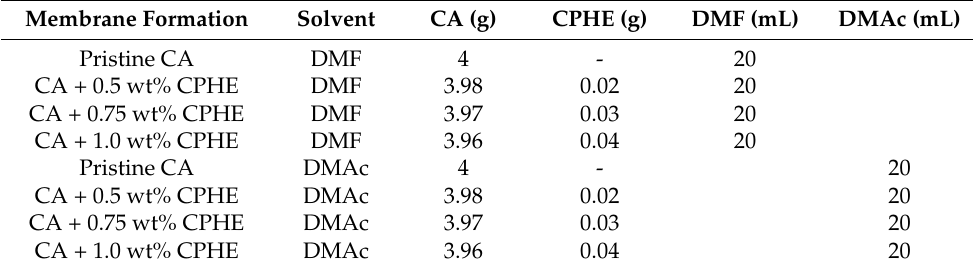
Table 1. Combinations of CPHE nanopowder, CA, and solvents (dimethylformamide (DMF) or dimethylacetamide (DMAc)) used in this